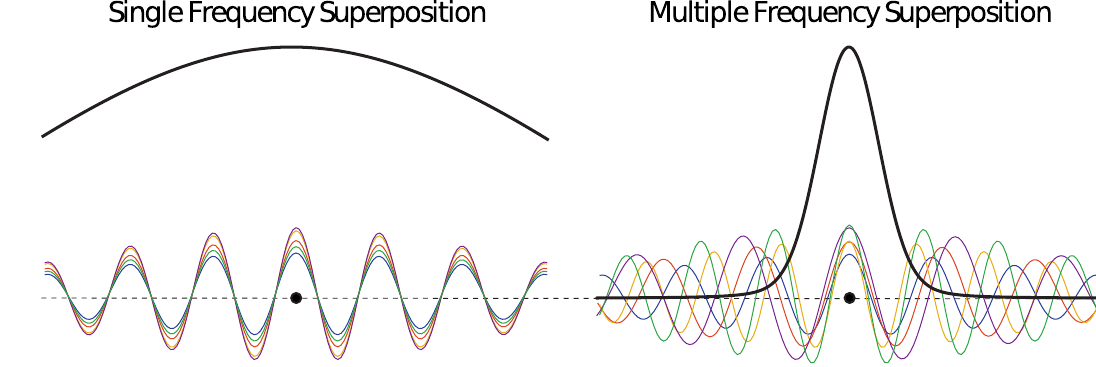
Figure 1. Label-free sharpening of focal field by emitting waves at distinct frequencies and at controlled times. In traditional emission beams (left), a superposition of waves of a single frequency leads to an elongated beam (solid black line). MFS (right) uses multiple frequencies emitted at times such as to amplify destructive interference outside the target, thus sharpening focus. The target is represented by the black